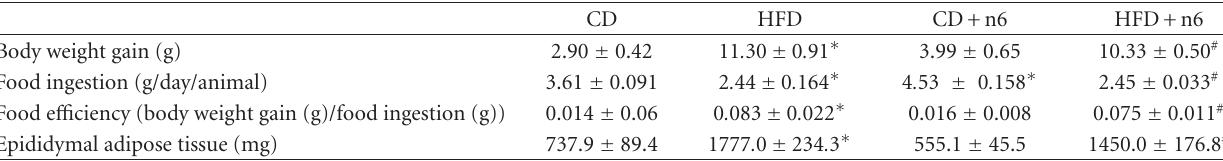
Table 1: Obesity characteristics from mice fed with control diet (CD) or high-fat diet (HFD), supplemented or not with sunflower oil (rich in n-6 fatty